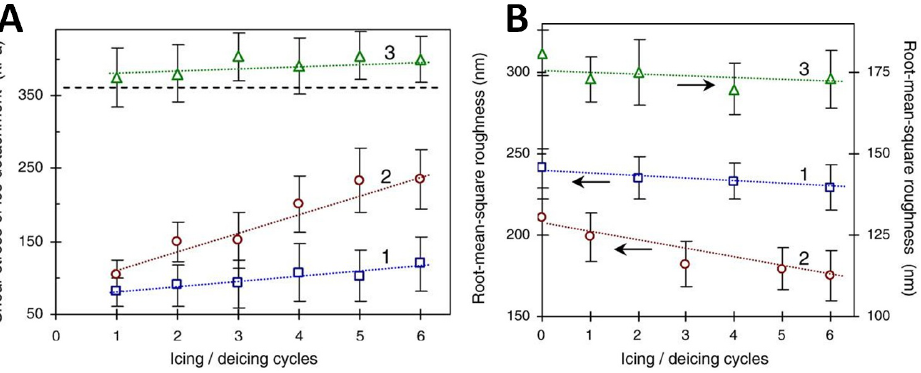
Figure 12. The effect of icing/de-icing cycles on ( A ) ice adhesion and ( B ) surface roughness, measured for “artificial” glaze ice for three samples with high contact angles (>150 ◦ ). Reprinted with permission from Ref. [132]. c (cid:13) 2011 Elsevier.